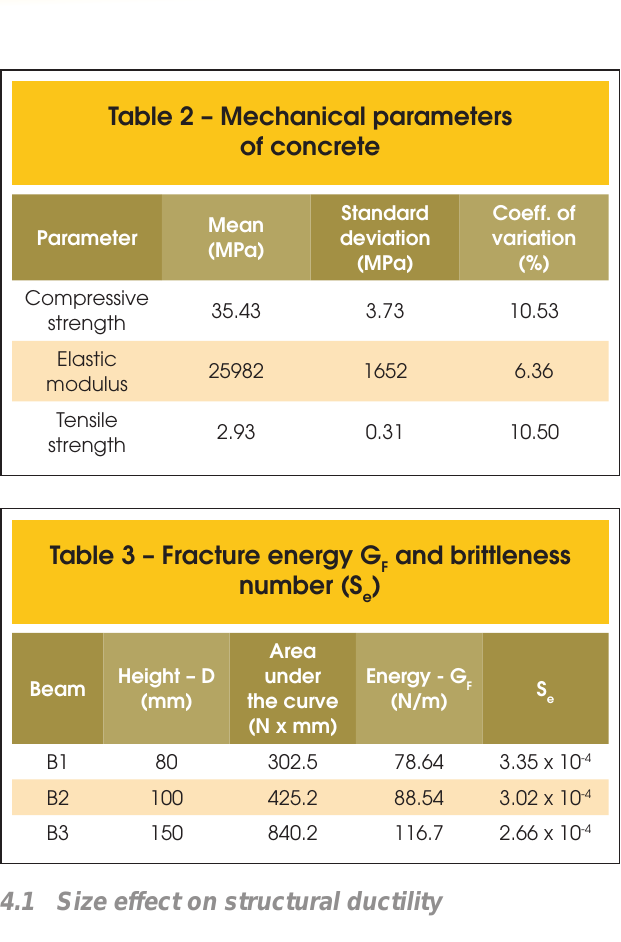
Figure 8 – Variation in fracture energy (G ) with specimen height